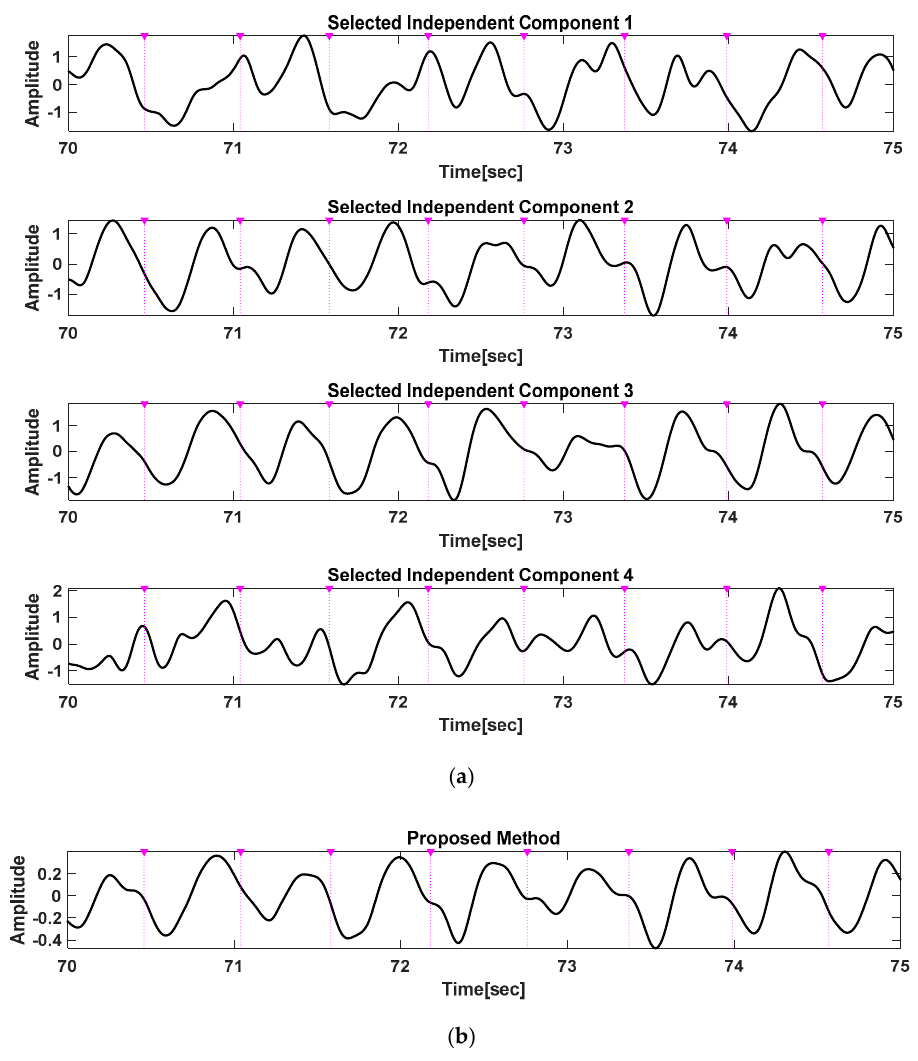
Figure 8. Selected independent components and motion artifact reduced PPG signals. ( a ) Selected ICs applying the reverse-check and pulsatile component selection algorithm, ( b ) reconstructed PPG signal based on the truncated SVD.